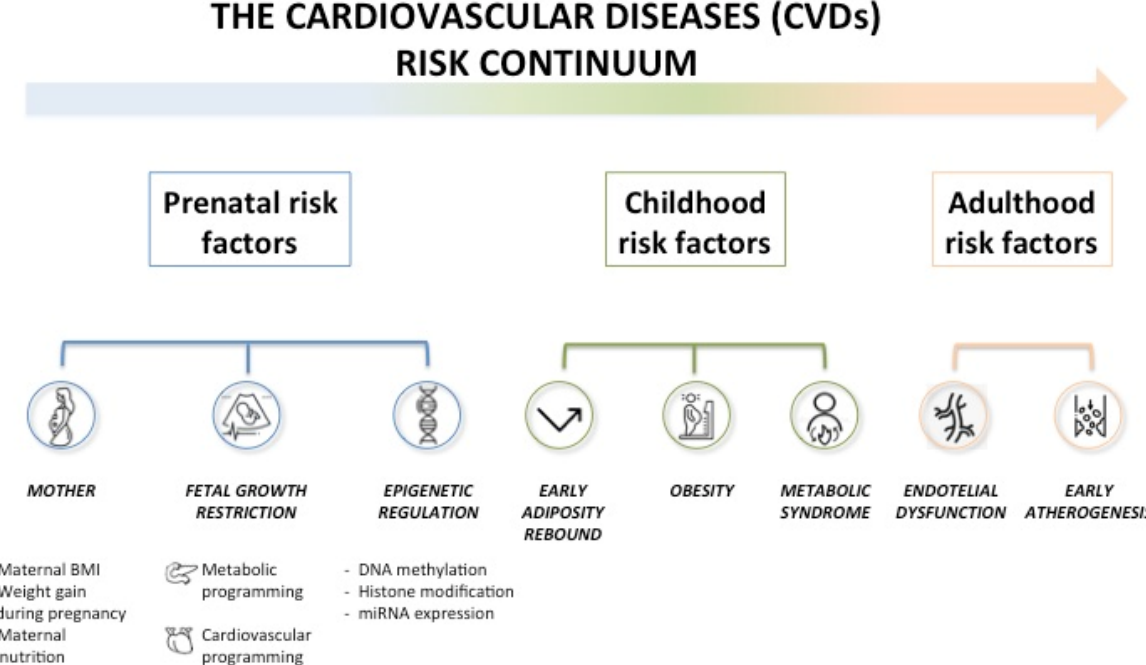
Figure 1. The cardiovascular disease (CVD) risk continuum.